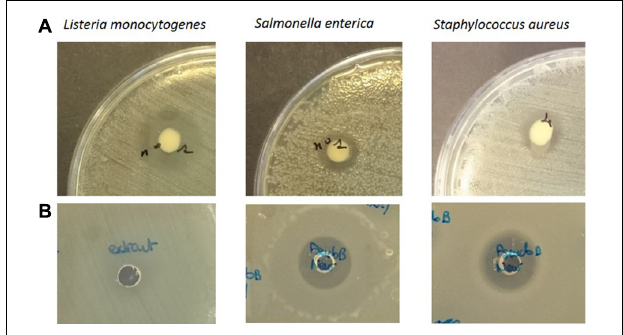
FIGURE 2 | Spot on the lawn assay of Pseudomonas sp. UCMA 17988 (A) and well diffusion assay of biosurfactants crude extract (B) against